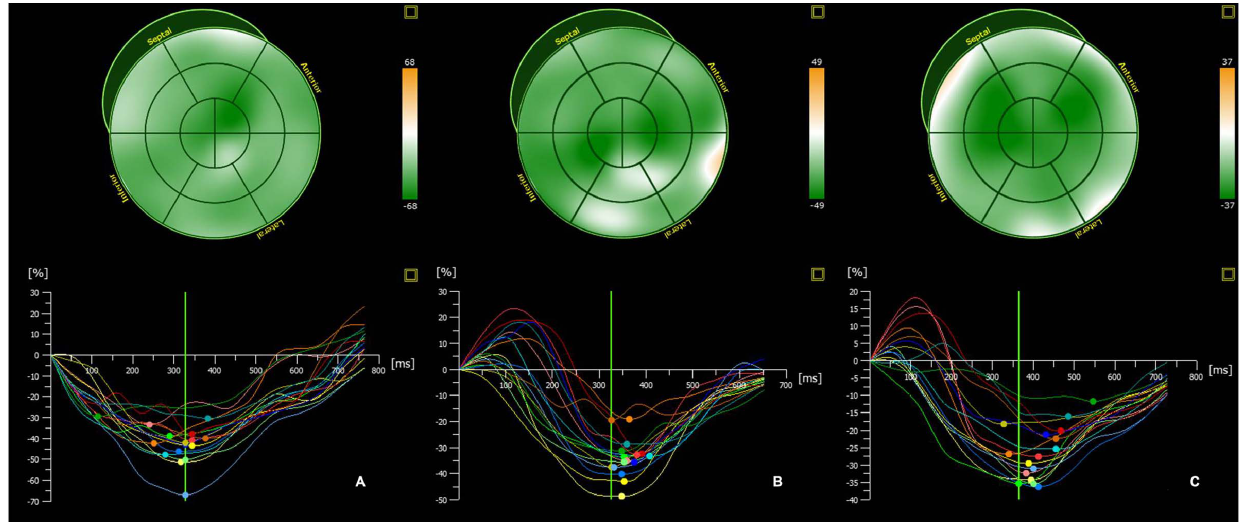
Figure 1. The three-dimensional strain curves of the 16 segments of LV in (A) the controls, (B) the patients in the hemodialysis group, and (C) the nondialysis patients. The color-coded curves indicate the different myocardial segments of the LV. The peak strain values of the different myocardial regions are more decreased in the uremic patients than in the controls. The peak strain is lowest in the nondialysis group. doi:10.1371/journal.pone.0100265.g001 PLOS ONE |